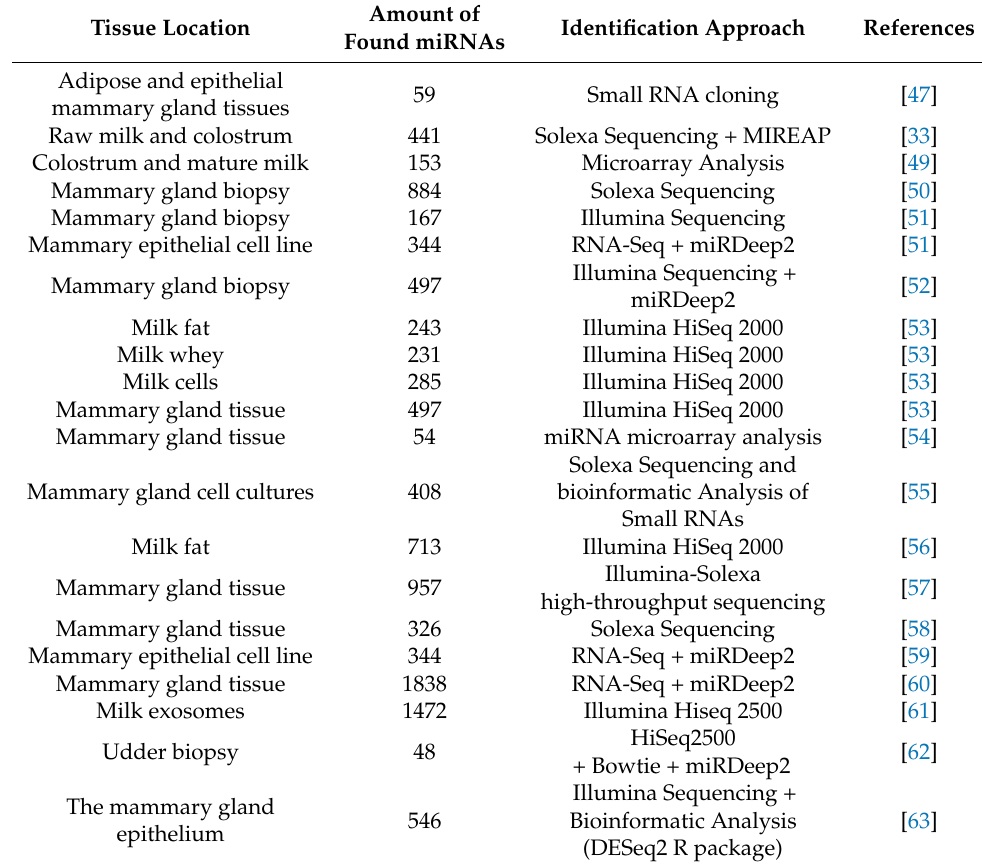
Table 1. A brief summary of miRNAs ever found in bovine mammary glands. Tissue